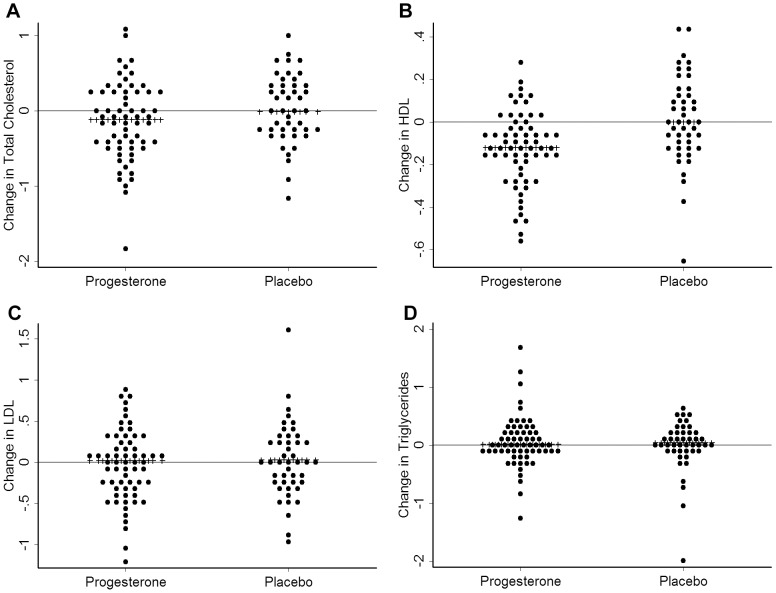
Changes in Lipids on Progesterone or Placebo.These graphs show dot plots of lipid changes in 108 healthy early postmenopausal women in a randomized controlled trial of oral micronized progesterone (Progesterone, 300 mg daily) for hot flushes between the 4-week run-in and the 12 weeks of experimental therapy. Women were randomized in a 1∶1 ratio to Progesterone (n = 63) or Placebo (n = 45). The median change is shown with a line of stars. A. Total Cholesterol changes—not different by therapy; B. High density lipoprotein cholesterol = HDC-C—the level during Progesterone therapy was significantly lower (−0.14 mmol/L, p = 0.001)( 95% CI of difference, −0.20, −0.07); C. Low density lipoprotein cholesterol = LDL-C—not different by therapy; D. Triglycerides—not different by therapy.